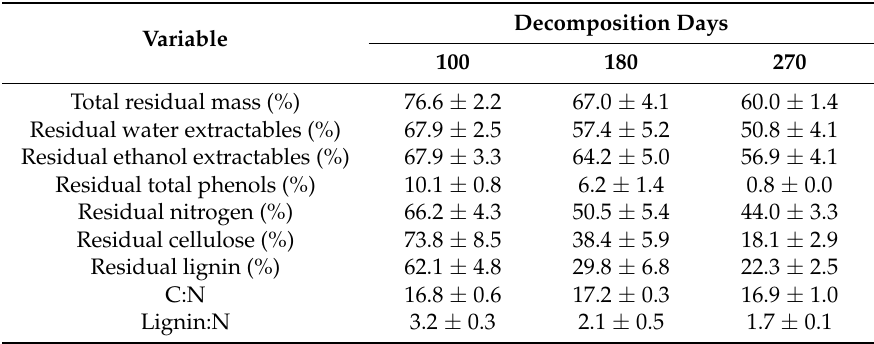
Table 2. Dynamics of residual masses, C:N and Lignin:N in the litterbag experiment. Values represent mean ± standard error of the mean ( N =